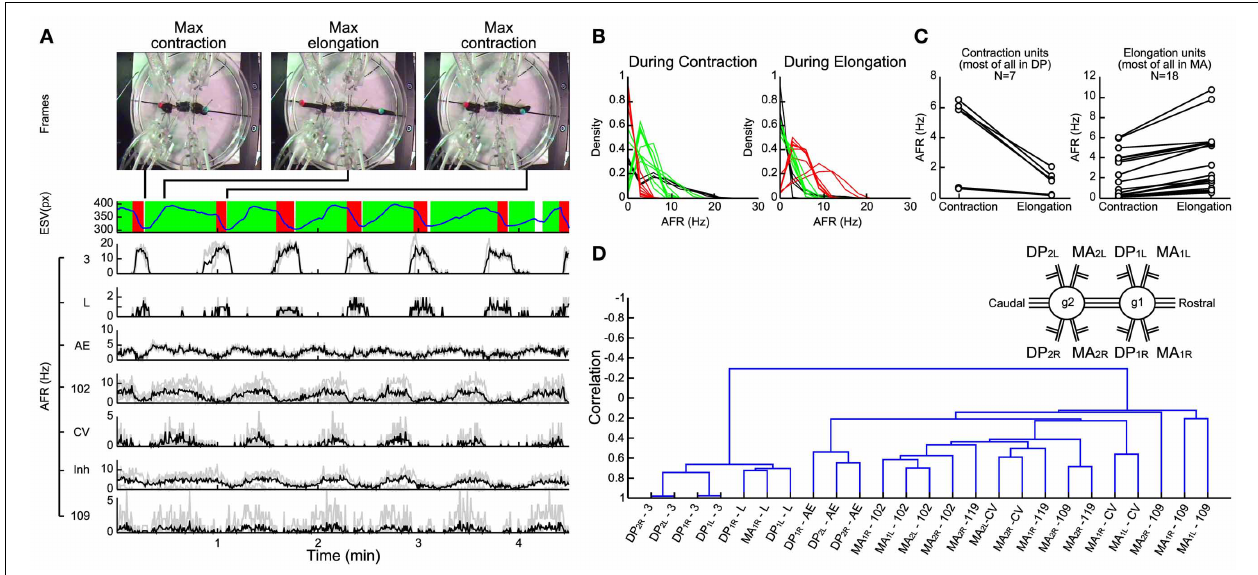
FIGURE 5 | Electrical patterns underlying crawling. (A) Frames from a crawling episode performed by the leech: whole body contraction (first frame), elongation (second frame), and a new contraction (third frame) which corresponded to the temporal performing elongation signal (blue trace below). The contraction phase (red) and the elongation phase (green) were defined by processing the first time-derivative of the elongation. A custom supervised AP-sorting algorithm was run on the 8 available electrical recordings (4 DPs and 4 MAs). Twenty-five different units were detected, classified, and presented (3, L, AE, 102, CV, and 109). The AFR from other unidentified inhibitors was averaged (indicated as Inh). (B) Density plots of the average firing rate of each unit during contraction (left plot) and elongation phases (right plot). Three families of neurons were distinguished: pure